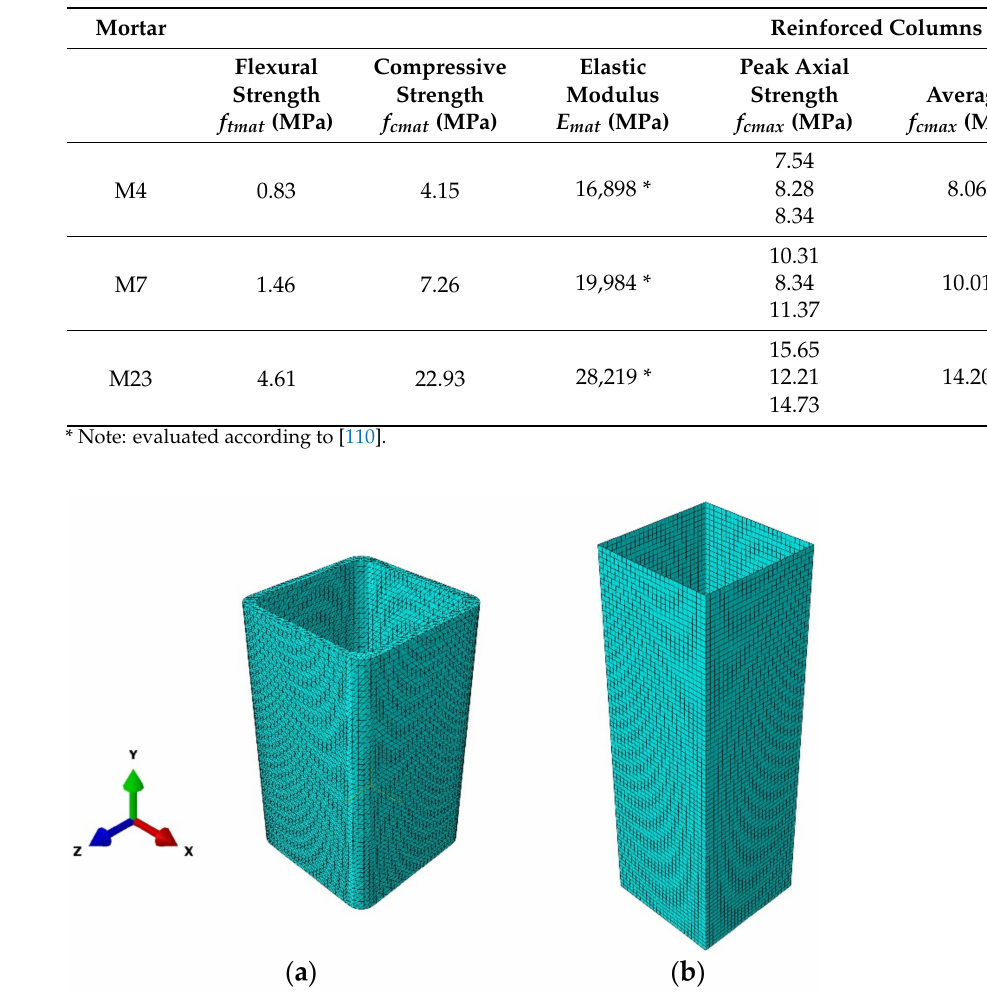
Table 3. Statistical values of the mortar and the results of reinforced columns reported in [65].